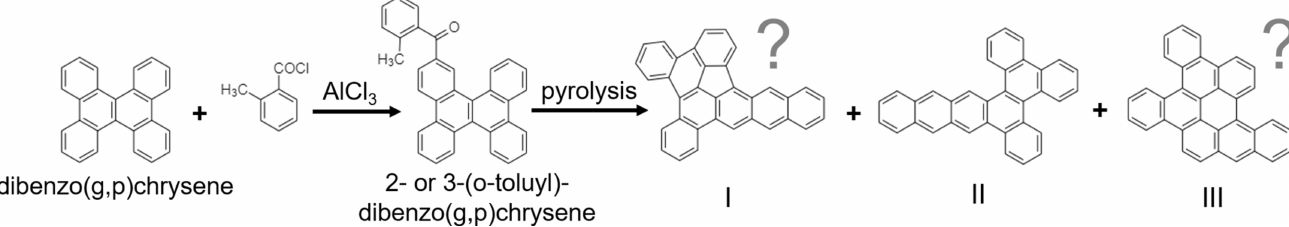
Figure 1 A stepwise model of the synthesis of benzo[ e ]dinaphtho[2,3- a ;1 0 ,2 0 ,3 0 ,4 0 - ghi ]fluoranthene (I) and related products (II and III). The molecule of I was considered provisional before its structure determination by 3D ED, whereas the molecular structure of III is still